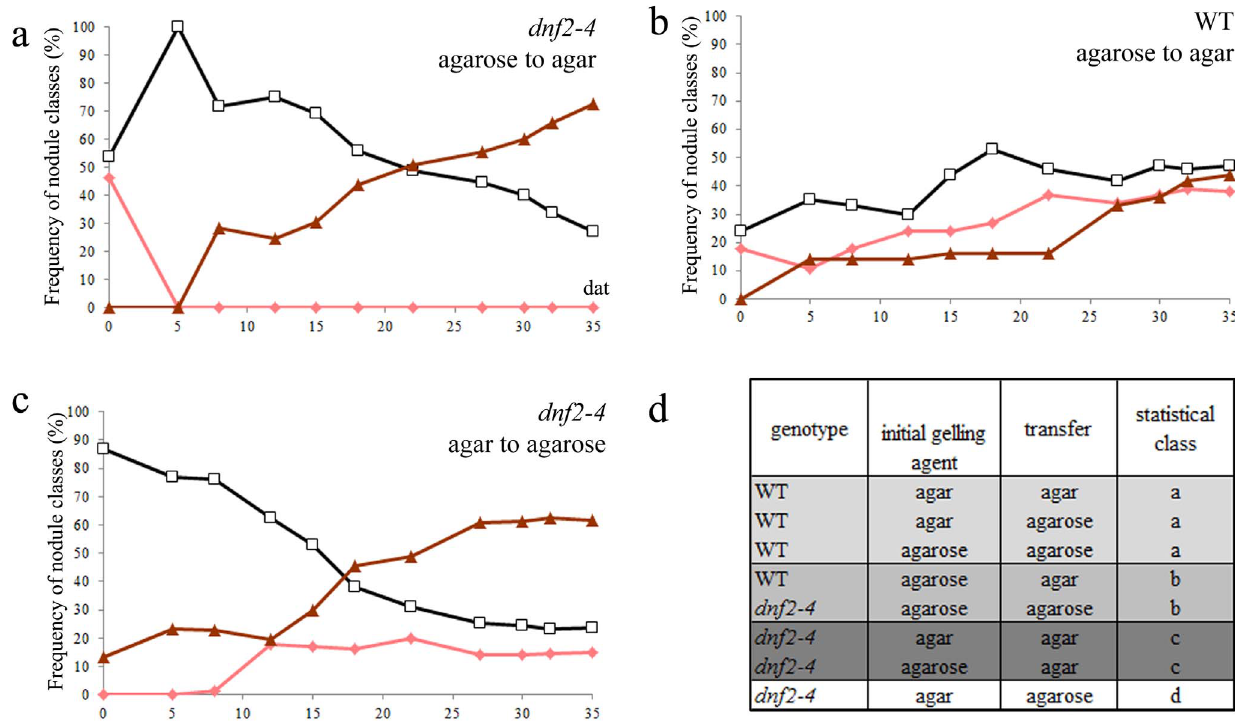
Figure 4. Influence of the plant growth conditions on dnf2 phenotype is transient. (a–c) Frequencies of nodule classes after transfer to agar or agarose medium. M. truncatula dnf2–4 and WT plants (n=24 for every conditions) inoculated with S. meliloti Rm41 were cultivated in vitro on BNM using agar or agarose as a gelling agent for 14 days and transfer to new medium with the same or different gelling agent. Pink nodules are represented by diamonds, white nodules by open squares and brownish nodules by triangles. The experiment was repeated three times with similar results. (d) analysis of the distribution of nodule classes at 35 days after transfer. Statistically identical distribution are attributed identical letters (Chi- Square Test of Homogeneity with Bonferroni correction,